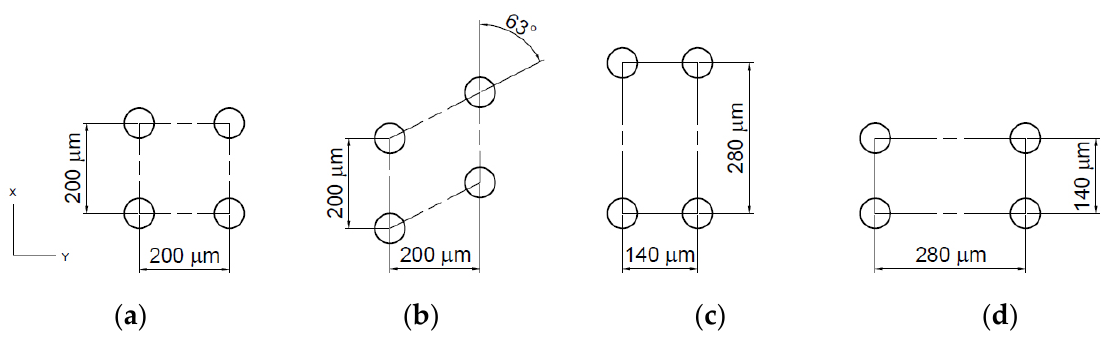
Figure 24. Array modes in the cylinder liner: square array ( a ), stagger array ( b ), stretching along the